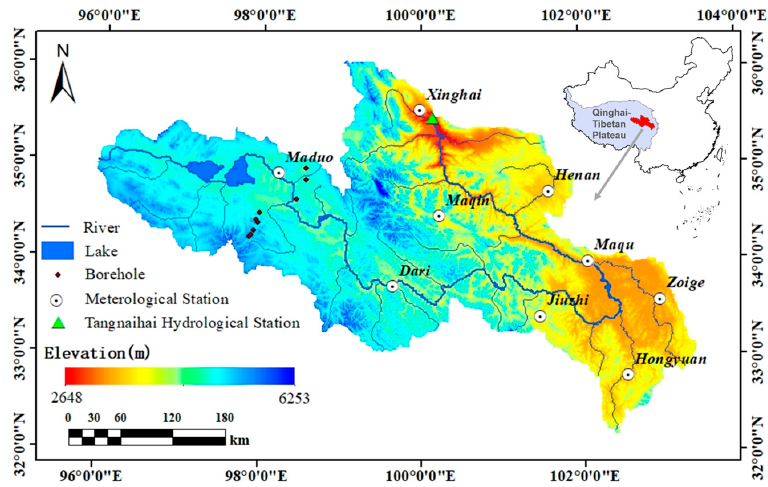
Figure 1. Study area and the locations of the meteorological stations.